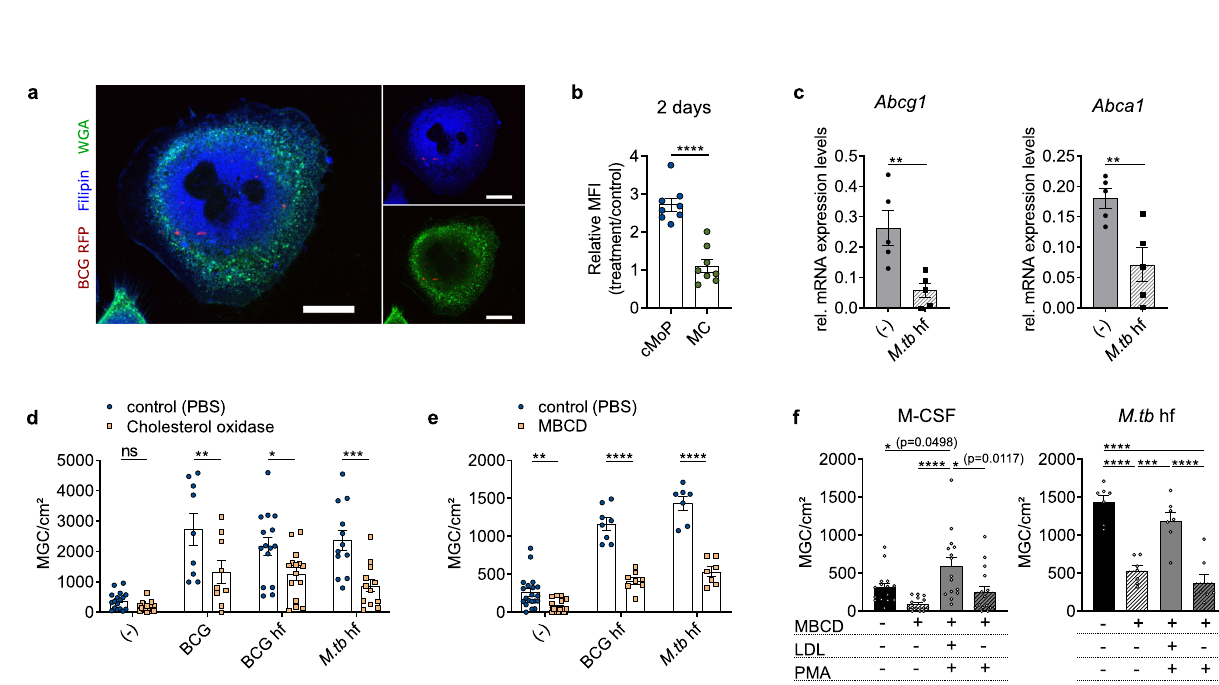
Fig. 3 cMoP-derived M Φ keep their potential to form MGC and show a characteristic metabolic pro fi le. a Dot plot of cMoP analyzed immediately after isolation for initial surface marker expression. Surface marker expression of cMoP and MC from Cx3cr1 gfp/ + mice analyzed by FACS related to CD45 + cells after 4, 8, 12 or 48 hours in culture with M-CSF. Depicted are mean ± SEM of n = 3 – 4 (CD117), n = 5 – 9 (CD11b), n = 3 – 5 (F4/80) biologically independent samples. Detailed sample numbers ( n ) are presented in Supplementary Table 4. ns = not signi fi cant, * p = 0.0161, *** p = 0.0009 (CD117), *** p = 0.0005 (CD11b), **** p < 0.0001 (two-way ANOVA, Sidak ’ s MCT). b Representative FACS dot plots for F4/80 and CD11b expression of cMoP and MC after 48 h in medium supplemented with M-CSF. c cMoP or MC from Cx3cr1 gfp/ + mice were stimulated either directly with LM (4 μ g/ml) for 4 days or after 2 days in culture with M-CSF (cond-cMoP, cond-MC). MGC formation was quanti fi ed based on Hemacolor stainings (scale bar: 100 µ m). Bars show mean ± SEM of n = 4 (cMoP) and n = 3 (MC) independent biological samples. ns = not signi fi cant (cMoP — cond-cMoP: p = 0.8162; MC — cond-MC: p = 0.9942), * p = 0.0256 (cMoP — MC), * p = 0.0109 (cond-cMoP — cond-MC), (one-way ANOVA, Tukey ’ s MCT). d Heatmaps of gene expression in cMoP and MC from Cx3cr1 gfp/ + mice after LM stimulation (4 µ g/ml, 48 hours) with M-CSF (50 ng/ml). M-CSF alone served as control (-). Depicted are standardized log2 differences of signi fi cantly up- (red) or downregulated (blue) genes in cMoP-LM compared to MC-LM or cMoP (-) compared to MC (-). The analysis was performed with two biologically independent samples per group (1 = sample 1; 2 = sample 2) by gene-ontology terms (GO-Terms), (GO:0006631 fatty acid metabolic process, GO:0008203 cholesterol metabolic process, GO:0001516 prostaglandin biosynthetic process, GO:0006694 steroid biosynthetic process, GO:0006869 lipid transport). If GO-Terms overlapped, respective genes were only assigned to one group. e Dhcr24 and Fasn mRNA expression levels relative to Gapdh in cMoP and MC, stimulated with LM (12 µ g/ml, light gray, diamonds) for 48 h compared to M-CSF control (dark gray, triangles) determined by qRT-PCR. Bars show mean ± SEM of n = 3 biologically independent samples. ** p = 0.0015 ( Dhcr24 ), ** p = 0.0091 ( Fasn ), *** p = 0.0005 (two-way ANOVA, Sidak ’ s MCT). f Panther pathway analysis of gene expression data described in Fig. 3d. Depicted are signi fi cantly up- (red) or downregulated (blue) pathways in cMoP-LM versus MC-LM.